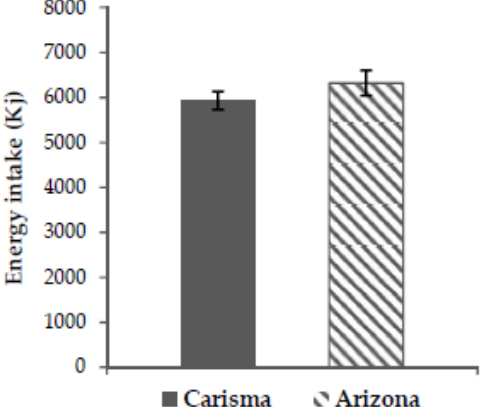
Figure 3. Unadjusted means for ad libitum energy intake ± SE. p = 0.105 (adjusted p -value). Carisma ® (low GI) and Arizona (high GI). SE, standard error; GI, glycaemic index.